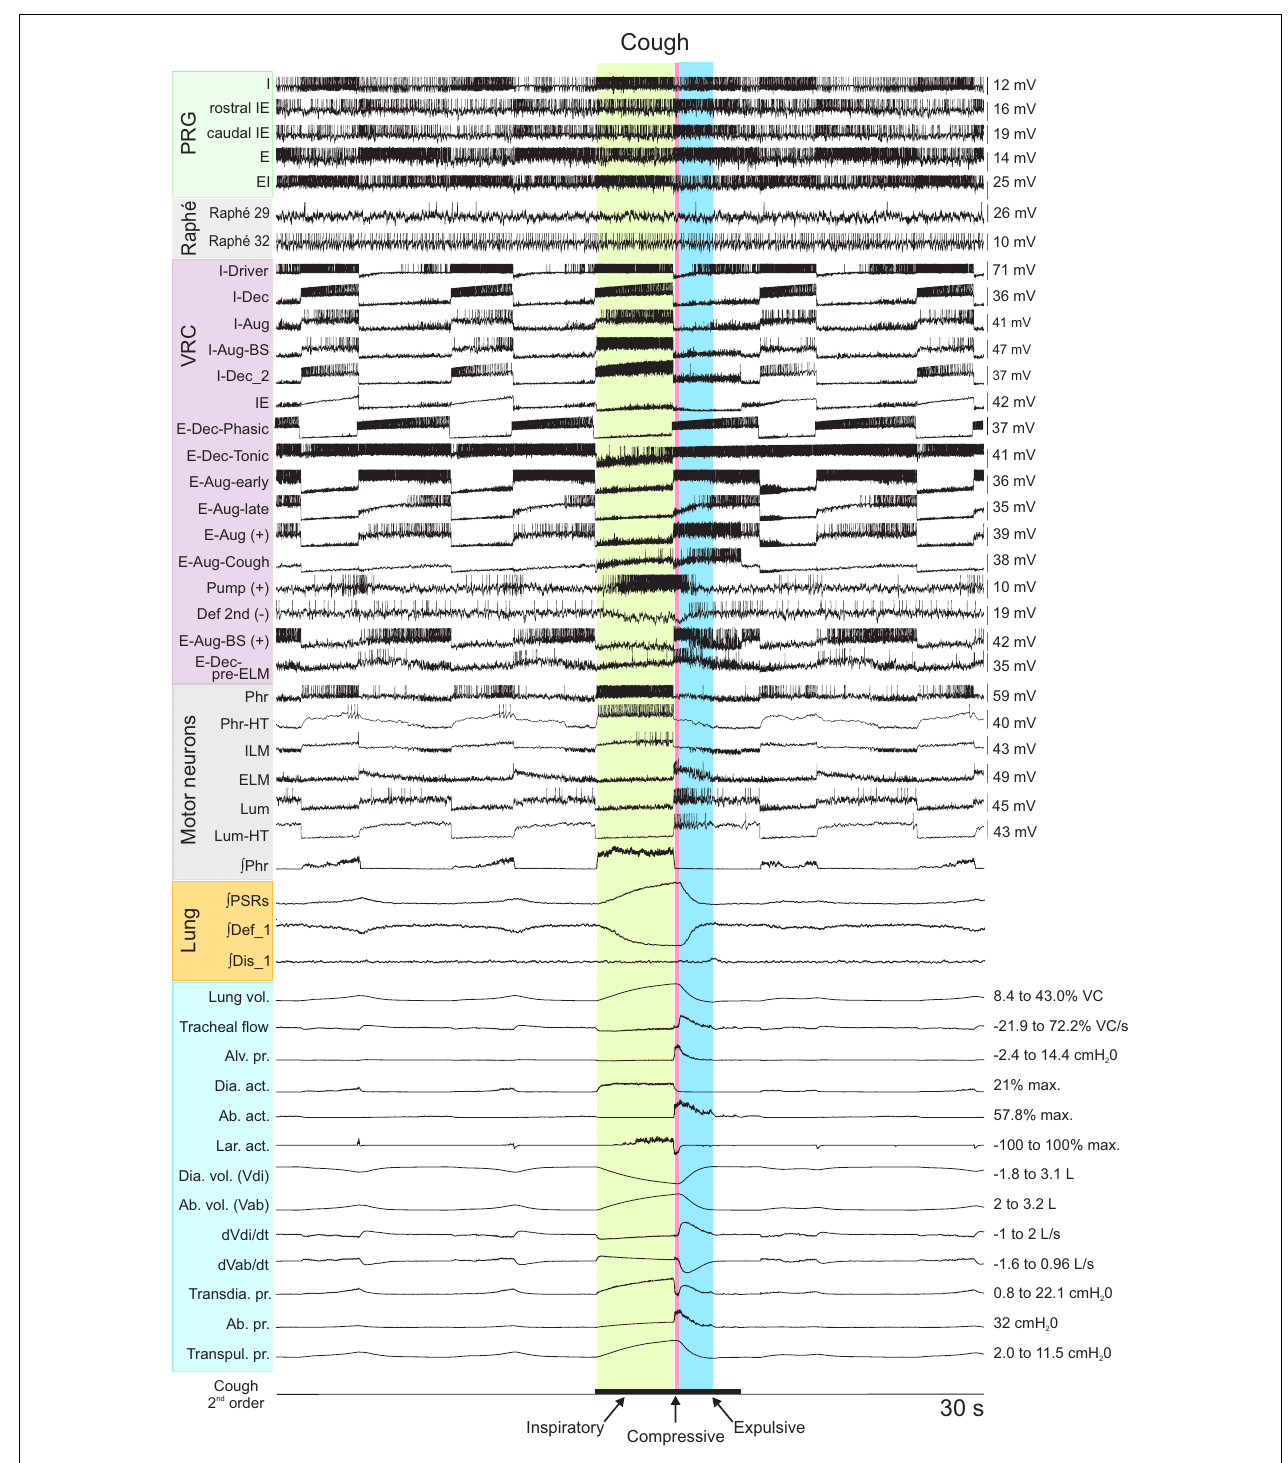
by the labels on the left, arranged by region (PRG, raphé,VRC) or type (Motor neuron populations).The “integrated” phrenic trace represents the threshold crossing activity of the “PHR” population summed over 60ms windows and indicates the inspiratory and expiratory phases of the respiratory